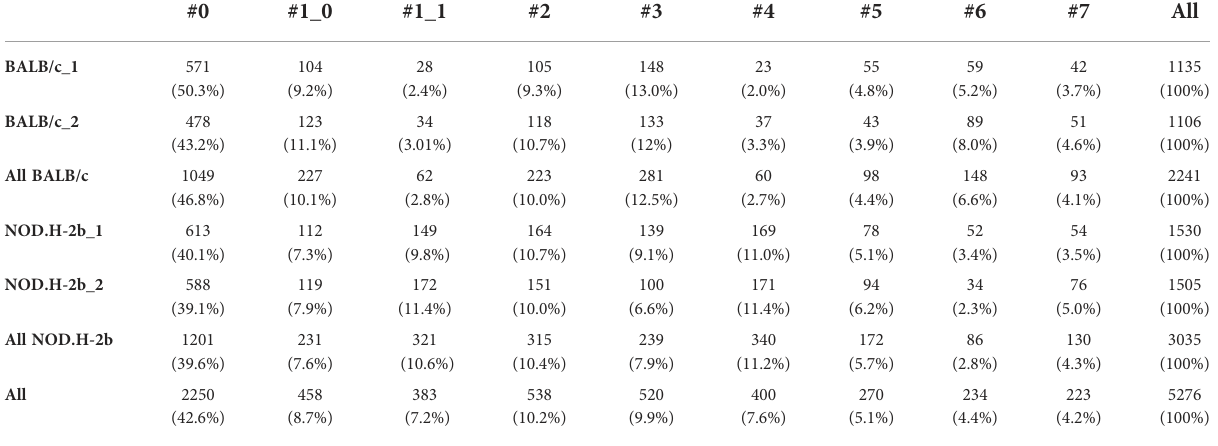
TABLE 2 Repartition of spot per cluster and per sample.